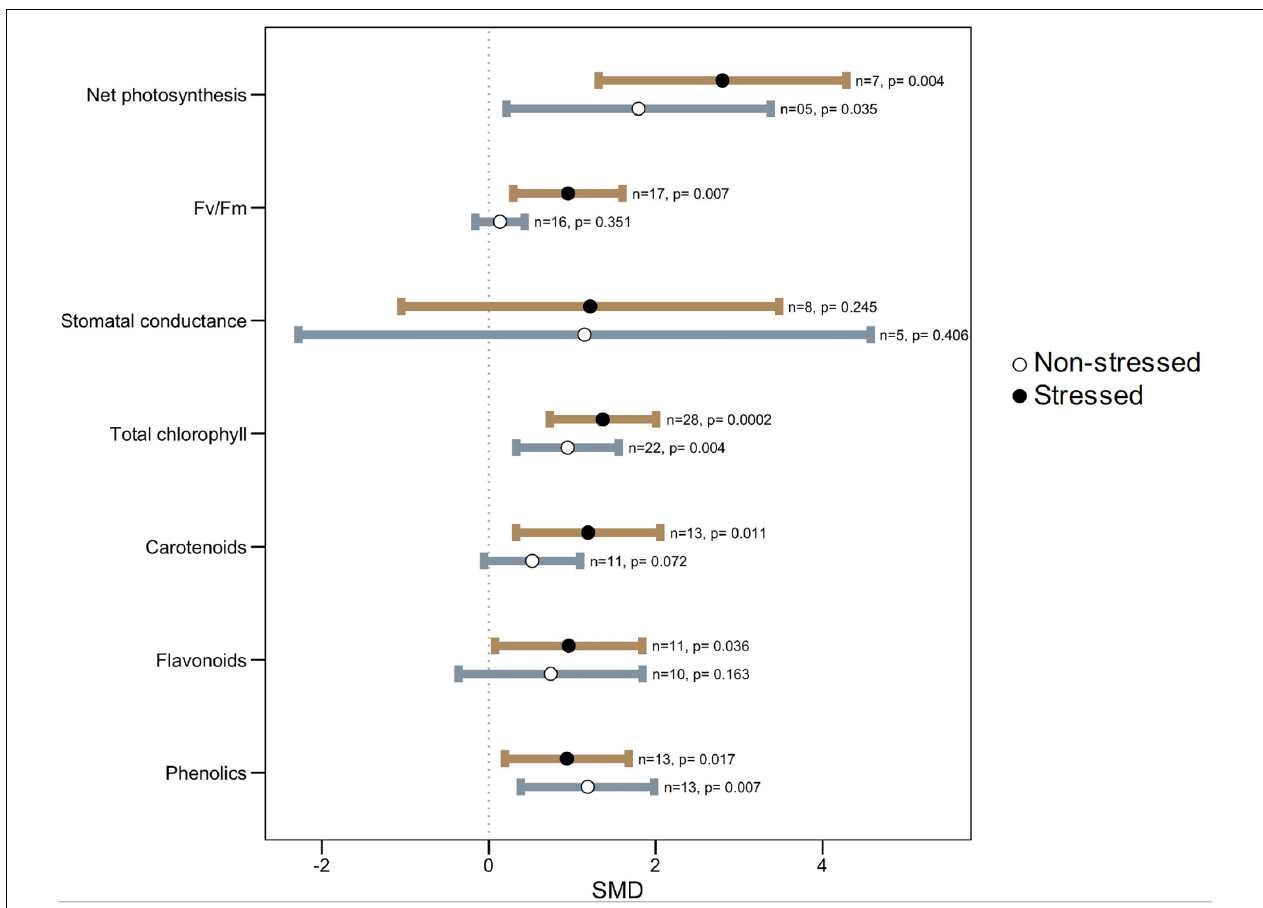
FIGURE 4 | Effect of microbe inoculation on photosynthetic parameters compared with those of non-inoculated plants under heat stress and non-stressed conditions. Error bars are effect size (SMD) means ± 95% CIs. Where the CIs do not overlap the vertical dashed lines, the effect size for a parameter is significant, i.e., the growth responses of inoculated plants were significantly different from those of non-inoculated plants. n = number of studies included in the meta-analysis, p = significance level of